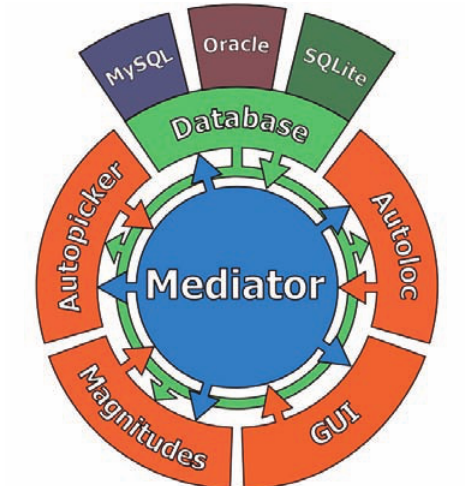
Figure 2. SeisComP3 System.